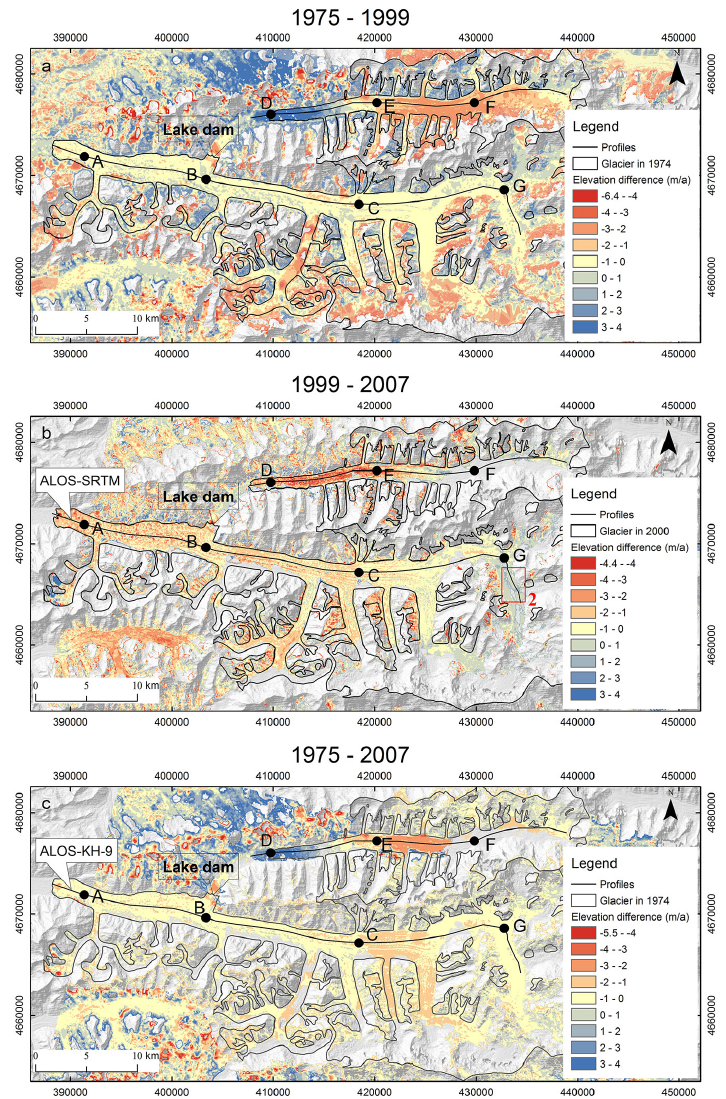
Figure 4. (a) Elevation difference of SIG and NIG between KH-9 ( ∼ 1975) and SRTM (1999); (b) elevation difference of SIG and NIG between SRTM (1999) and SPOT-5 (2007); (c) elevation difference of SIG and NIG between KH-9 ( ∼ 1975) and SPOT (2007). The altitude of points A, B, C, D, E, F and G are ∼ 3080, ∼ 3400, ∼ 3860, ∼ 3430, ∼ 3685, ∼ 4000 and ∼ 4410ma.s.l., respectively, derived from SRTM. Point A is on the edge of SPOT DEM and ALOS DEM. From the tongue of SIG to point A, the ice elevation differences are derived from KH-9–ALOS in (b) and SRTM–ALOS in (c) . Point C and point E are on the boundary of KH-9 in 1974 and KH-9 in 1976; region 2 is the accumulation region of SIG in (b)